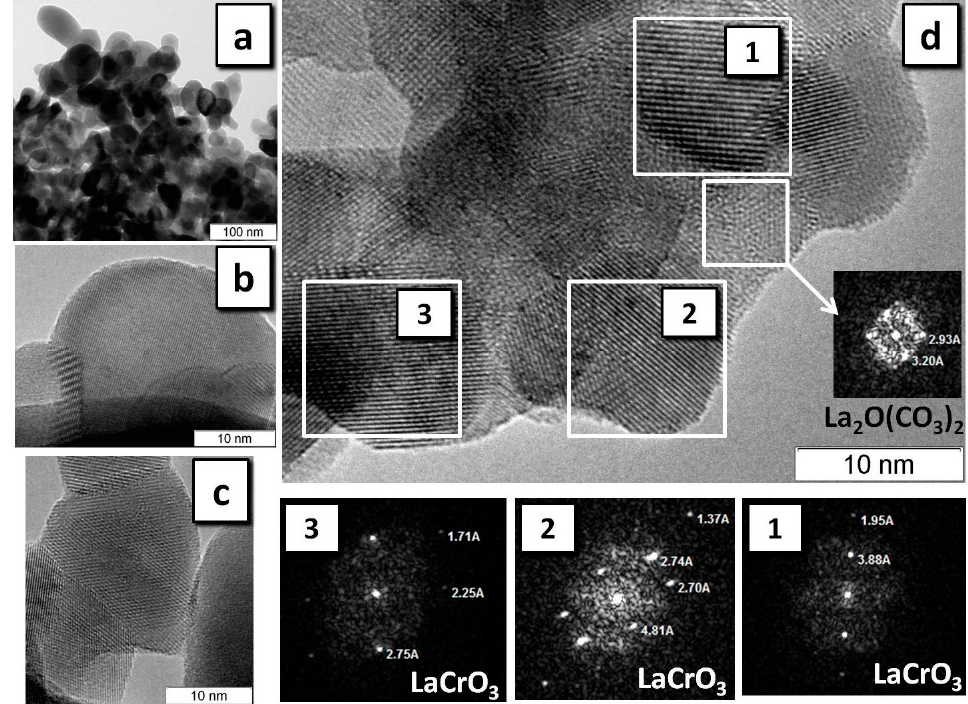
Figure 7. HRTEM of LaCrO 3 obtained in the SHS regime: LaCrO 3 phase with resolution of ( a ) 100 nm and ( b , c ) 10 nm for di ff erent particles; ( d ) the selected areas and their di ff raction patterns (1), (2), and